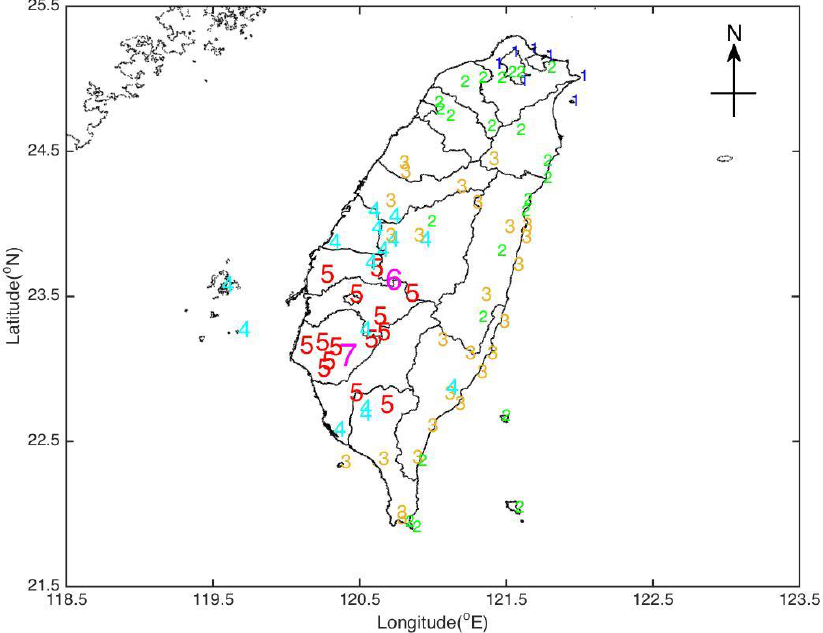
Figure 4. The intensity scale distribution reported by the CWB for the earthquake occurring on 6 February 2016.